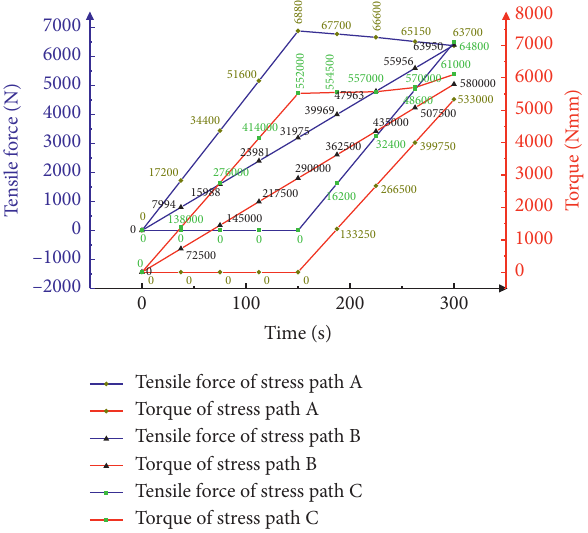
Figure 11: Three different stress path loading schemes.